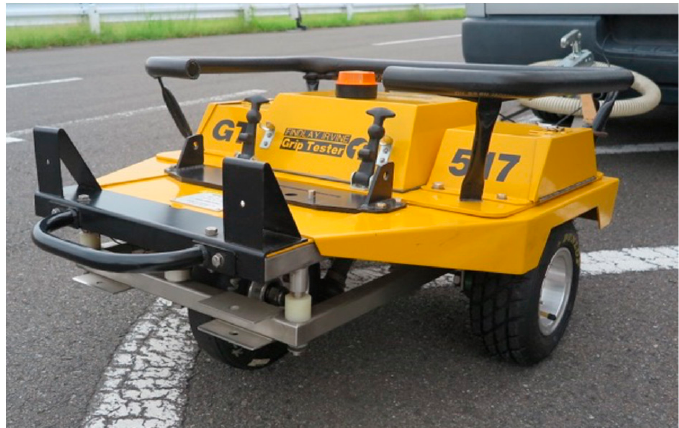
Figure 6. Grip Tester used in the experiment.